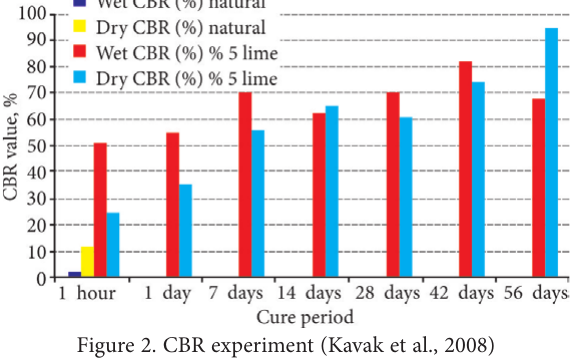
Figure 2. CBR experiment (Kavak et al., 2008)